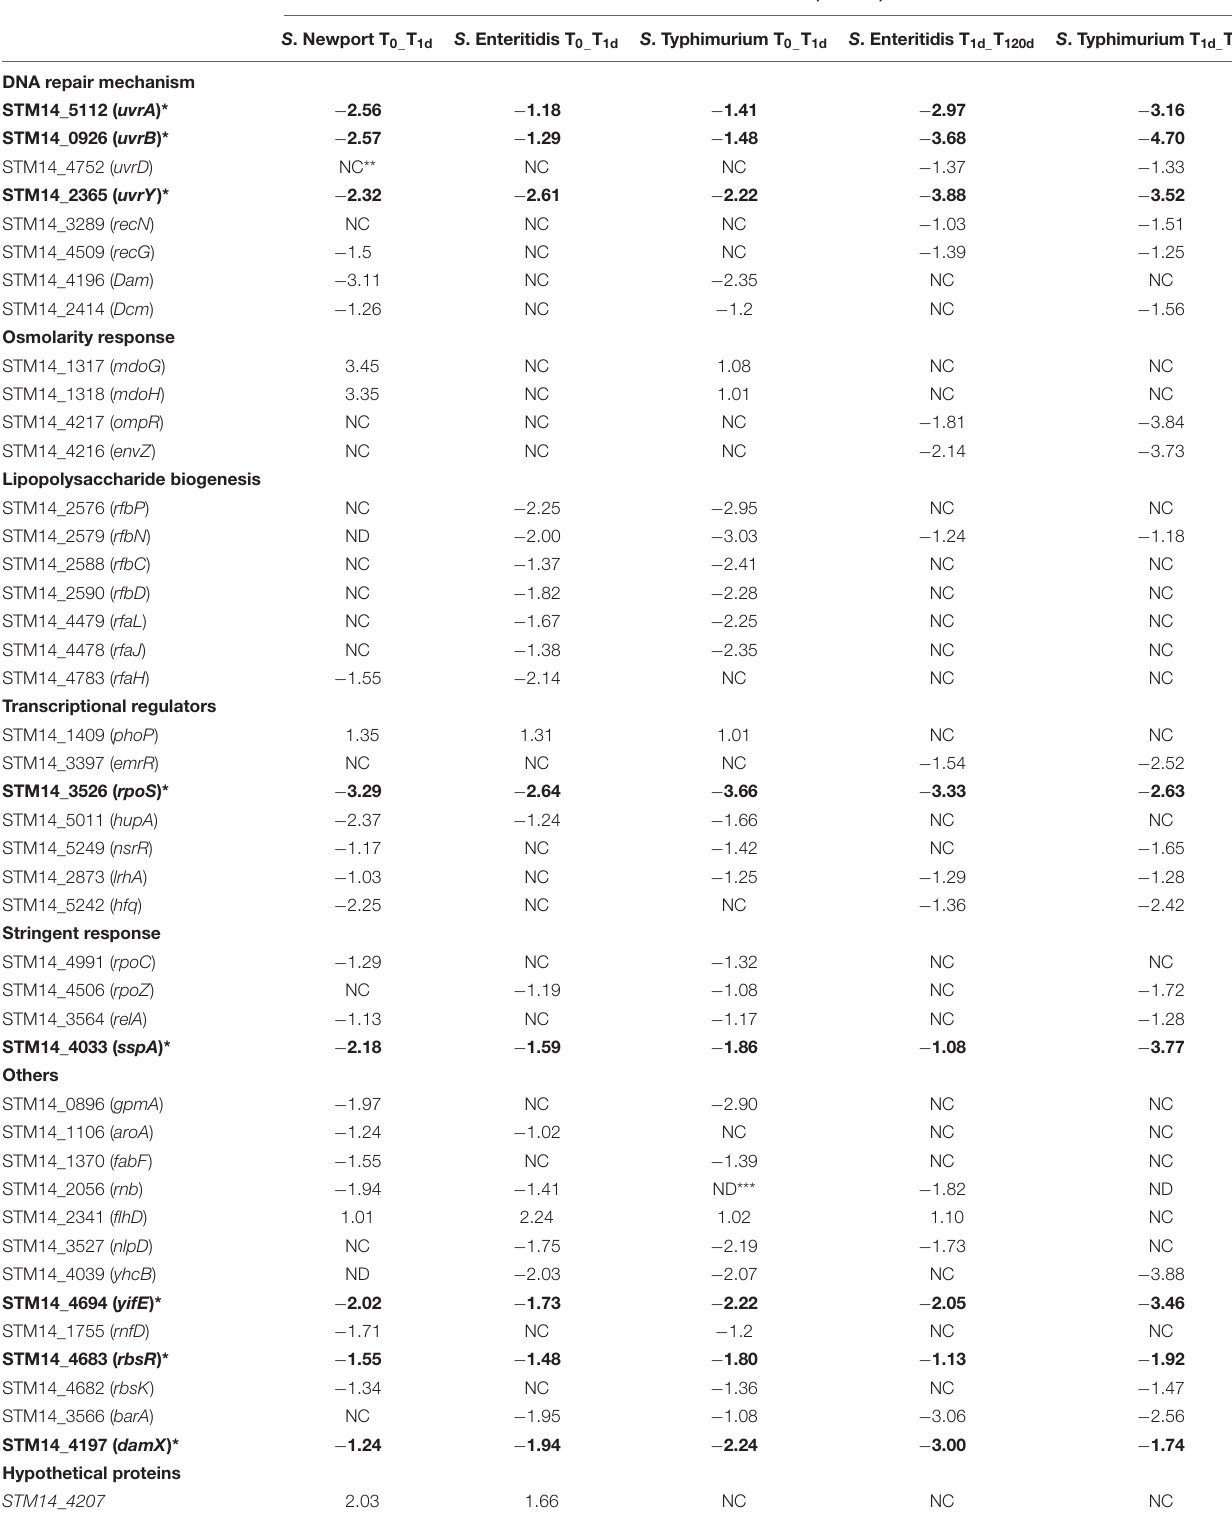
TABLE 1 | Genes under selection in at least two different